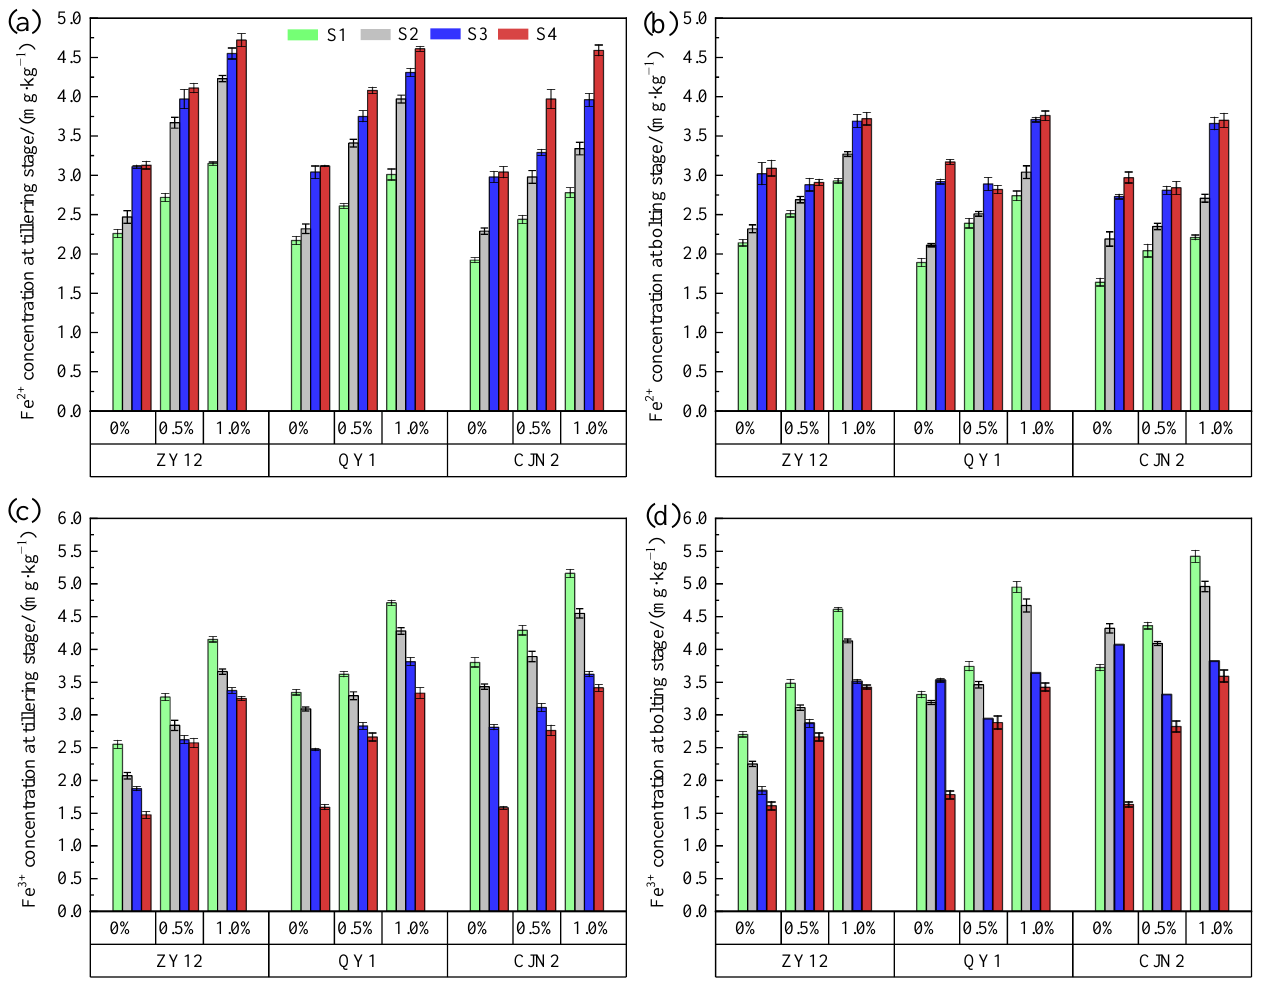
Figure 6. Effect of red mud (RM) on Fe 3+ and Fe 2+ concentrations in different soil zones. ( a ) Fe 2+ concentration in different zones at tillering stage; ( b ) Fe 2+ concentration in different zones at bolting stage; ( c ) Fe 3+ concentration in different zones at tillering stage; ( d ) Fe 3+ concentration in different zones at bolting stage. S1, S2, S3, and S4 indicate different soil zones in rhizoboxes.